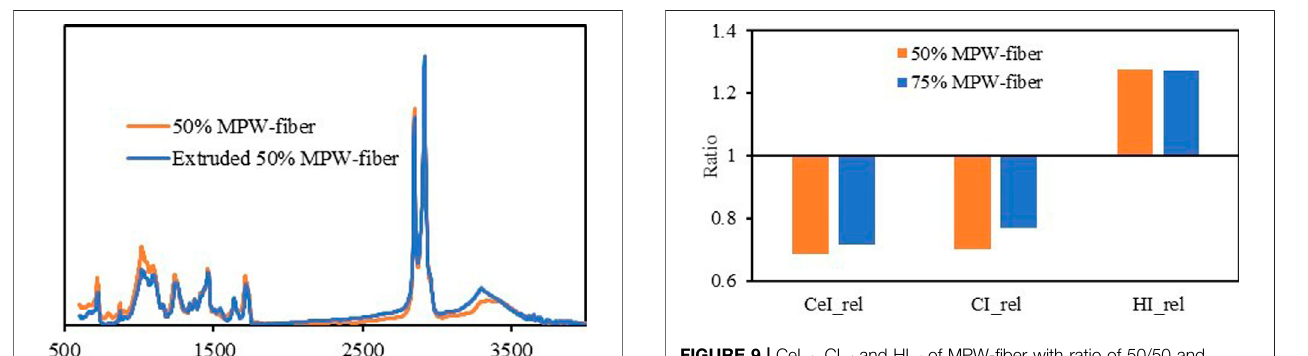
FIGURE 9 | CeI rel , CI rel and HI rel of MPW- fi ber with ratio of 50/50 and 75/25.